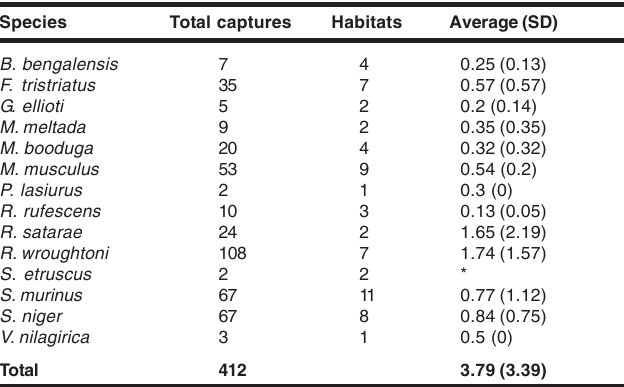
Table 3. Average trap success of non-volant small mammals in Coorg Species Total